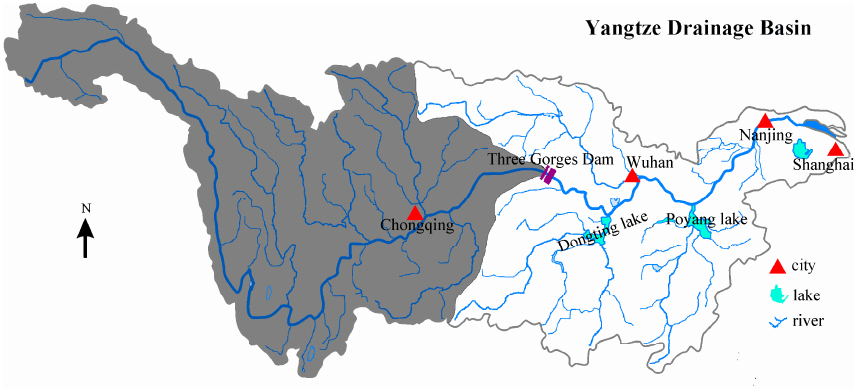
Figure 1. Yangtze River basin.